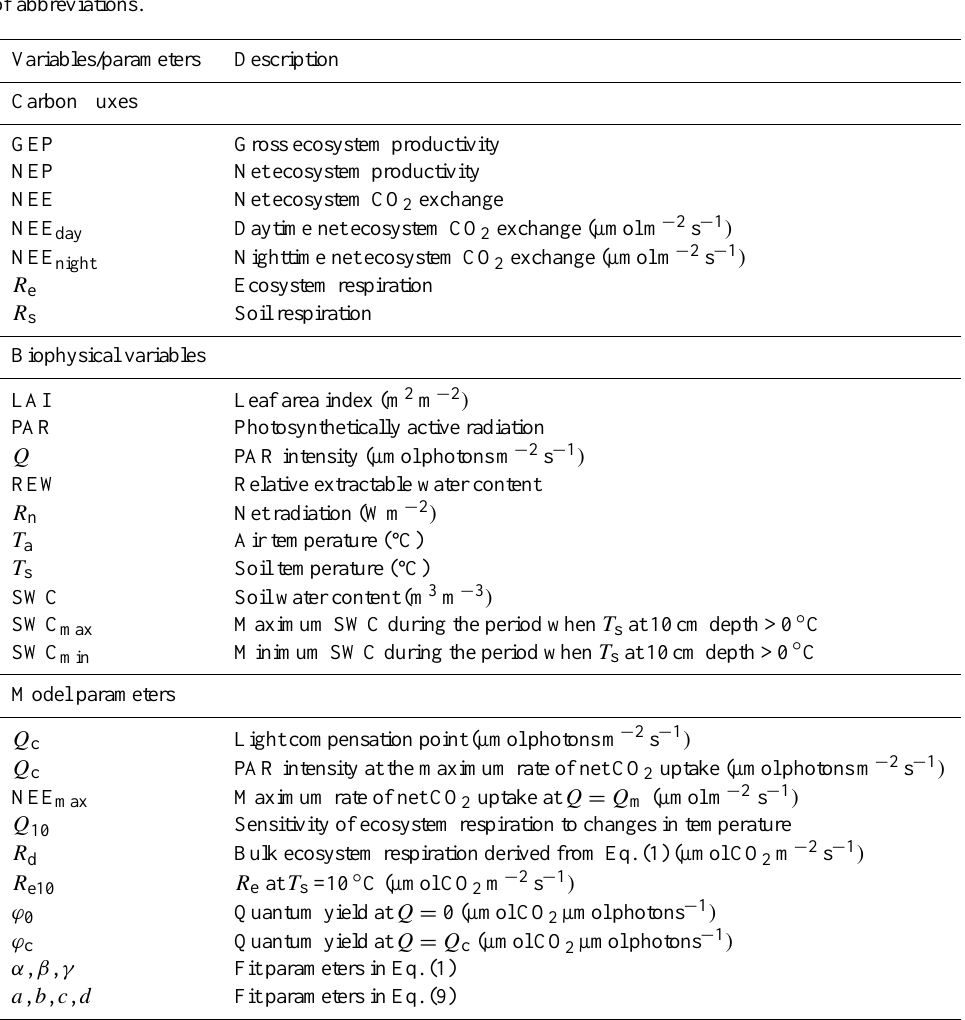
Table A1. List of abbreviations.